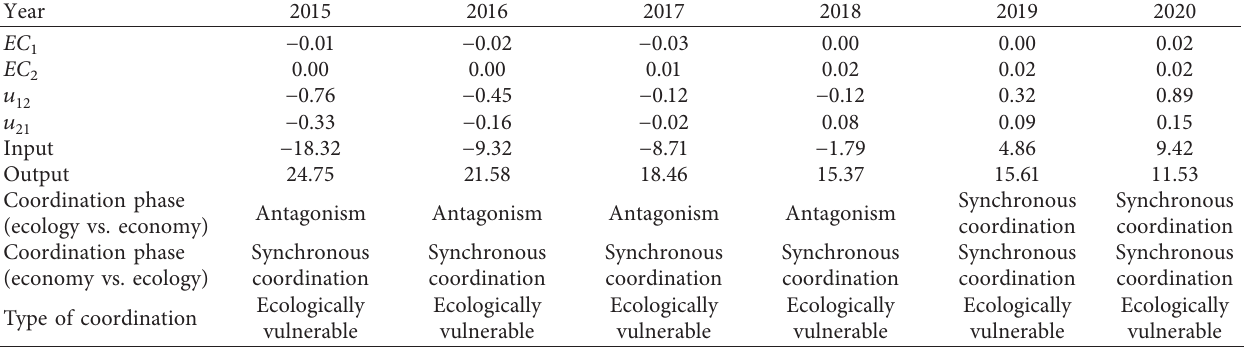
Table 2: Coordinated development of the complex system.